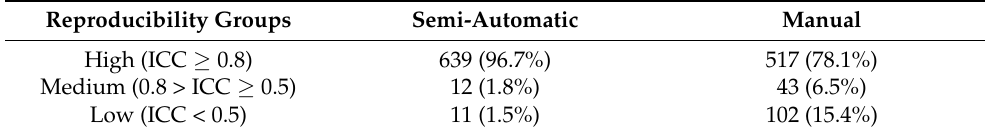
Table 5. Features extracted in different reproducibility groups.